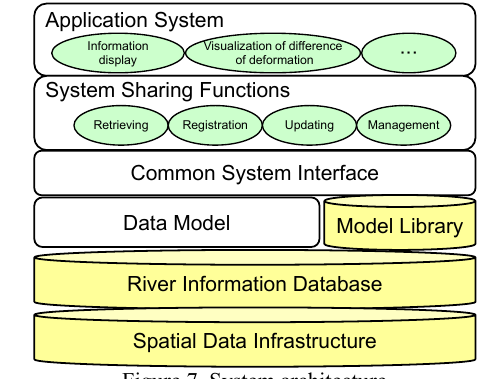
Figure 9. Information accumulated in the system